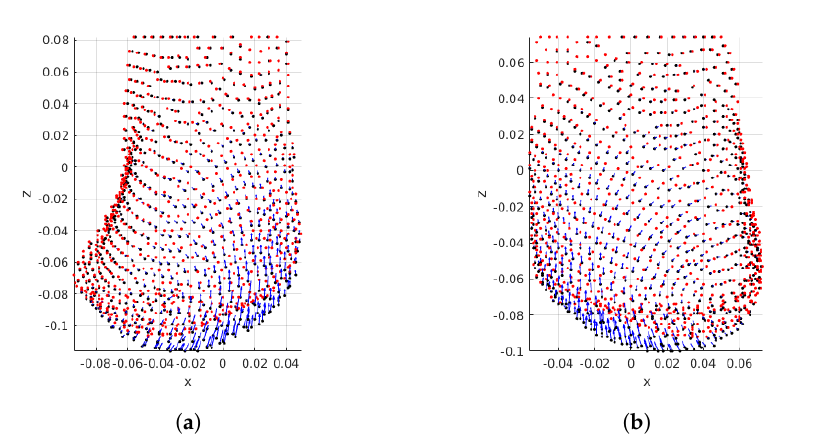
Figure 10. Influence of breast shape/laterality: PCLs are shown for two patients with BI-RADS A and the largest tumor positioned on UOQ. Pre- and post-surgical data on black and red, respectively. Blue arrows indicate displacement direction and magnitude. ( a ) Patient’s right breast; ( b ) Patient’s left